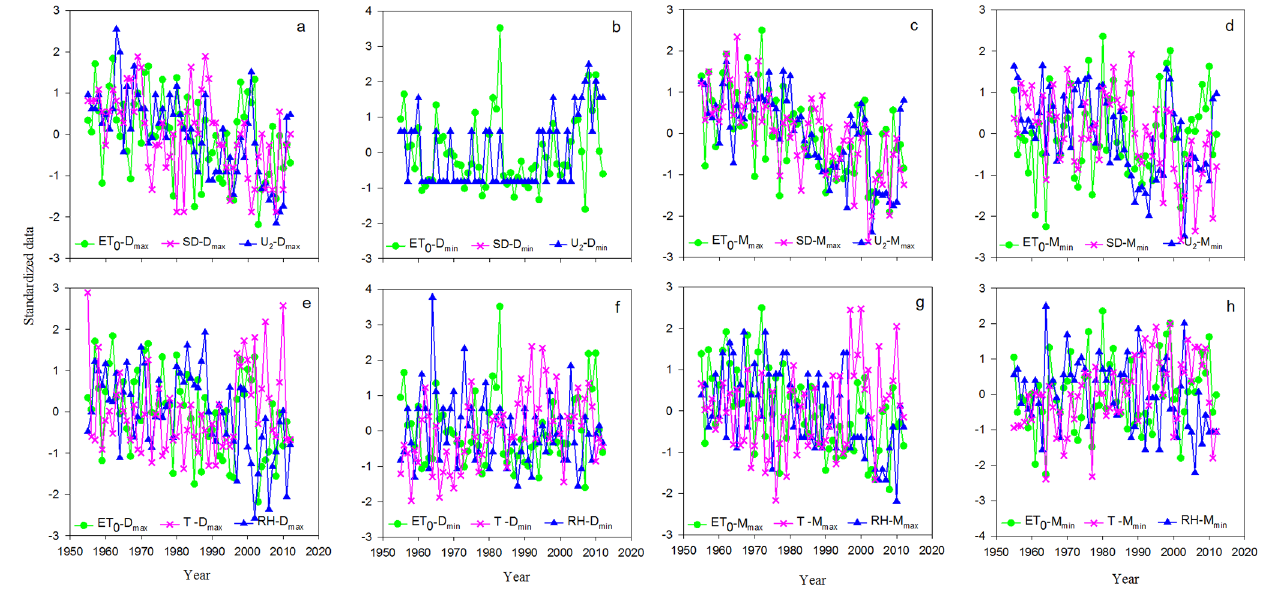
Figure 7. The evolution pattern of the extreme value of ET 0 and meteorological variables at daily scale (left two column panels) and monthly scales (right two column